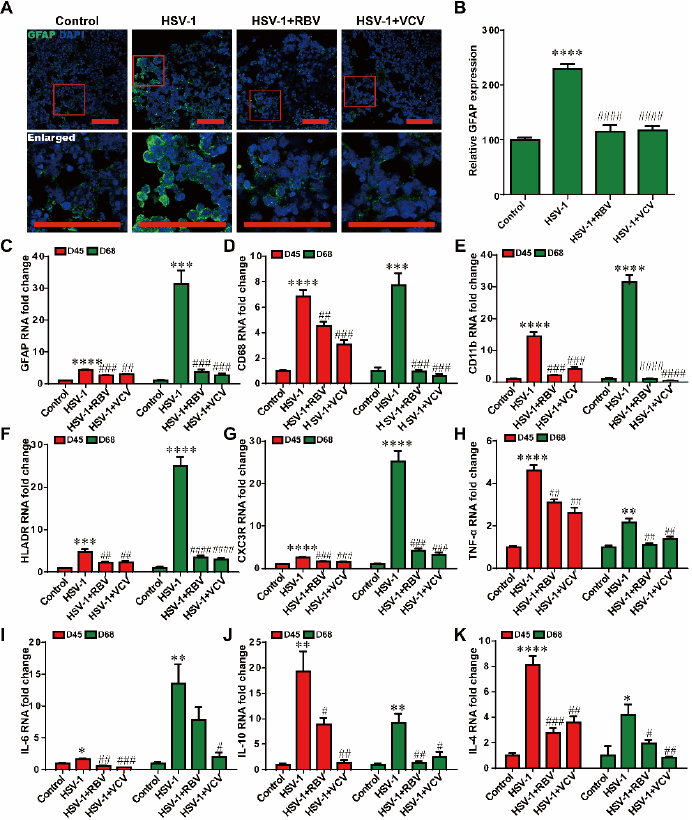
Figure 6. RBV and VCV treatments reduced reactive gliosis and neuroinflammation in the cerebral organoids. ( A ) The expression of GFAP was identified by immunofluorescence staining, and the quantifications ( B ) for relative fluorescence intensity statistics were shown, the red frame line is the position of the enlarged figure. Scale bars (red rectangle): 100 µm. ( C ) The mRNA expression of astrocyte cell marker ( GFAP ) was examined by RT-PCR in cerebral organoids in the different groups at D42 + 3 and D65 + 3. ( D – G ) The mRNA expression of microglia cell markers ( CD11b , CD68 , HLADR , and CXC3R ) and astrocyte cell marker ( GFAP ) were examined by RT-PCR in cerebral or- ganoids in the different groups at D42 + 3 and D65 + 3. ( H – K ) The mRNA expressions were quanti- fied for the pro-inflammatory ( TNF- α and IL-6 ) and anti-inflammatory ( IL-10 and IL-4 ) mediators. Data represent the mean ± SEM. * p < 0.05 vs. the control group, ** p < 0.01 vs. the control group, *** p < 0.005 vs. the control group, **** p < 0.001 vs. the control group, # p < 0.05 vs. the HSV-1 infection group, ## p < 0.01 vs. the HSV-1 infection group, ### p < 0.005 vs. the HSV-1 infection group, #### p < 0.001 vs. the HSV-1 infection group, ( n = 6). 2.6. RBV and VCV Treatments Reduced the Neuron Loss To further demonstrate the neuroprotective effects of these two antiviral drugs in the HSV-1 infected cerebral organoids. We also investigated the therapeutic effects of RBV and VCV on neuron loss. Strikingly, immunofluorescence analysis revealed that the cerebral organoids displayed a markedly decrease in the expressions of TUJ and MAP2 after HSV-1 infection at D65 + 3 (Figure 7A–C), and both the RBV and the VCV treatments had the recovery effect on the neuron fate commitment. Similarly, the HSV-1-infected cerebral organoids exhibited a low level of TUJ and MAP2 (Figure 7D,E) mRNA